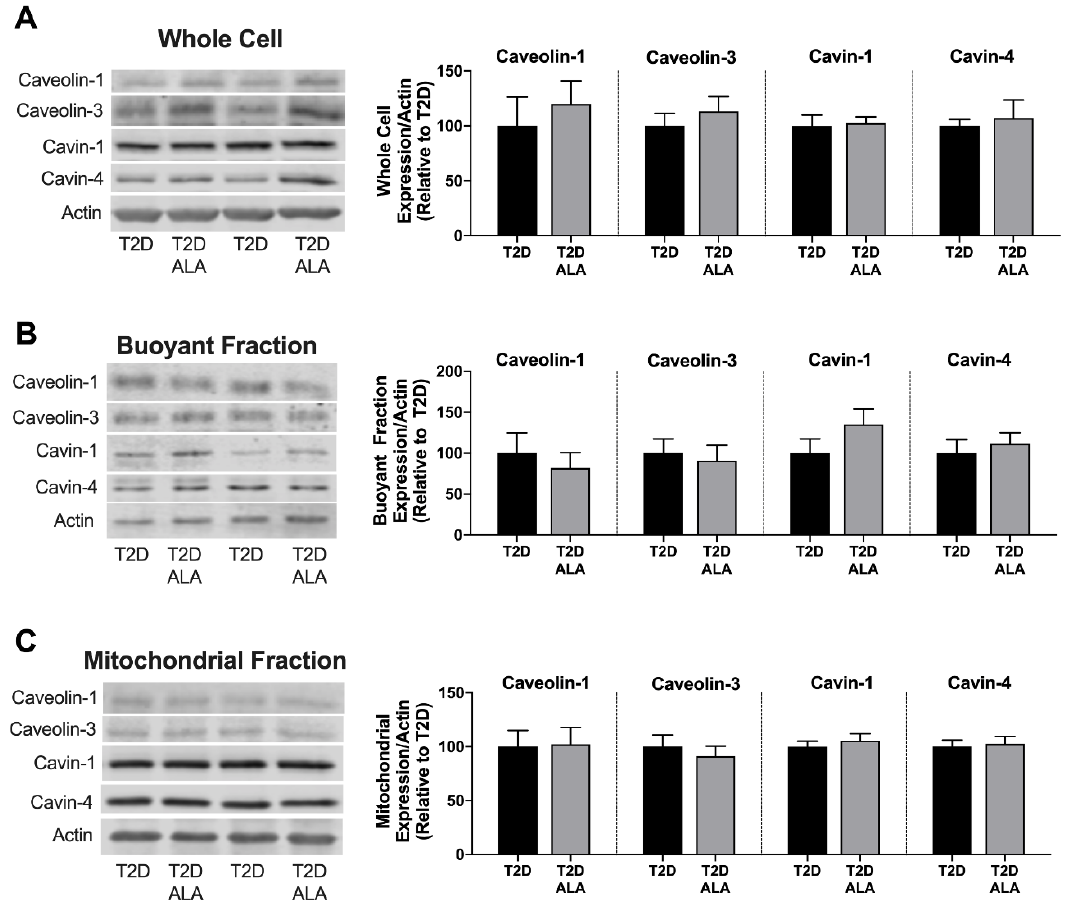
Figure 4. Total, buoyant membrane fraction and mitochondrial levels of caveolin and cavin proteins in hearts of T2D mice ± dietary ALA supplementation. Expression of caveolin-1, caveolin-3, cavin-1, and cavin-4 in ( A ) whole cell lysate; ( B ) buoyant (caveolae-enriched) fraction; and ( C ) mitochondrial fraction. Protein expression was normalized to actin in each blot and expressed relative to the untreated T2D group. Results presented as means±SEM ( n = 6/group for all proteins). No significant effects of ALA supplementation were detected.